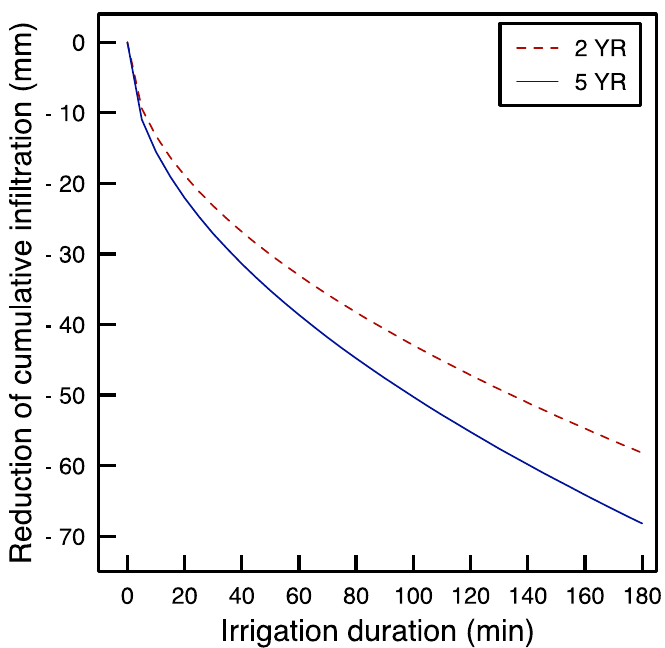
Figure 3. Cumulative infiltration curves obtained by Philip’s model for the three experimental plots subjected to different irrigation treatments (0YR, 2YR, and 5YR).